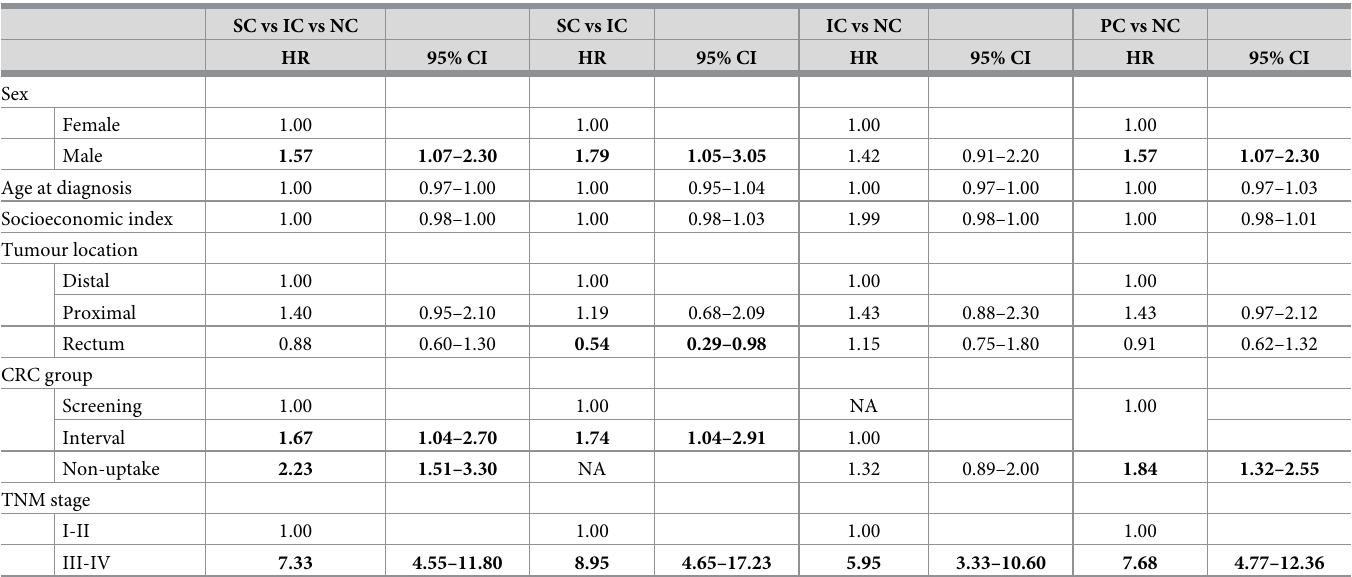
Table 2. Multivariate analyses for colorectal cancer mortality according to type of